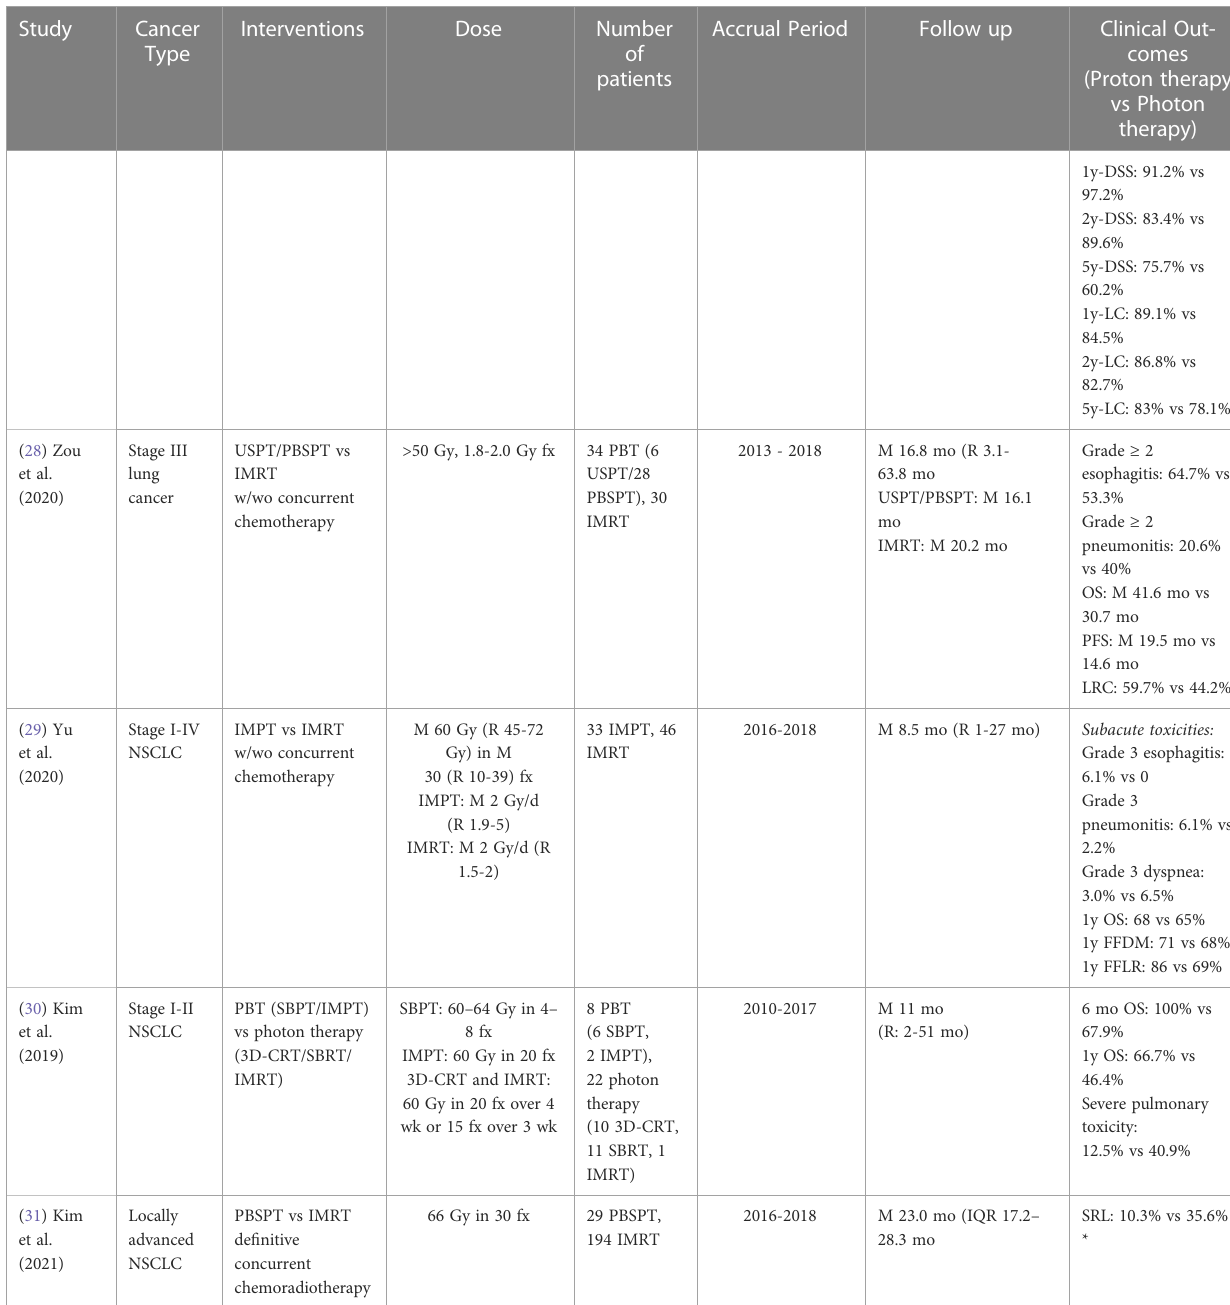
For stage T1-4N0-3 oropharyngeal cancer, a retrospective patient-reported outcome study from a symptom inventory-head and neck (MDASI-HN) module survey at MD Anderson indicated that there was a statistical reduction of top 5 symptom scores (food taste, dry mouth, swallowing/chewing, fatigue and appetite) in the IMPT group compared to the IMRT group during the subacute phase ( fi rst 3 months post- treatment) without adjusting